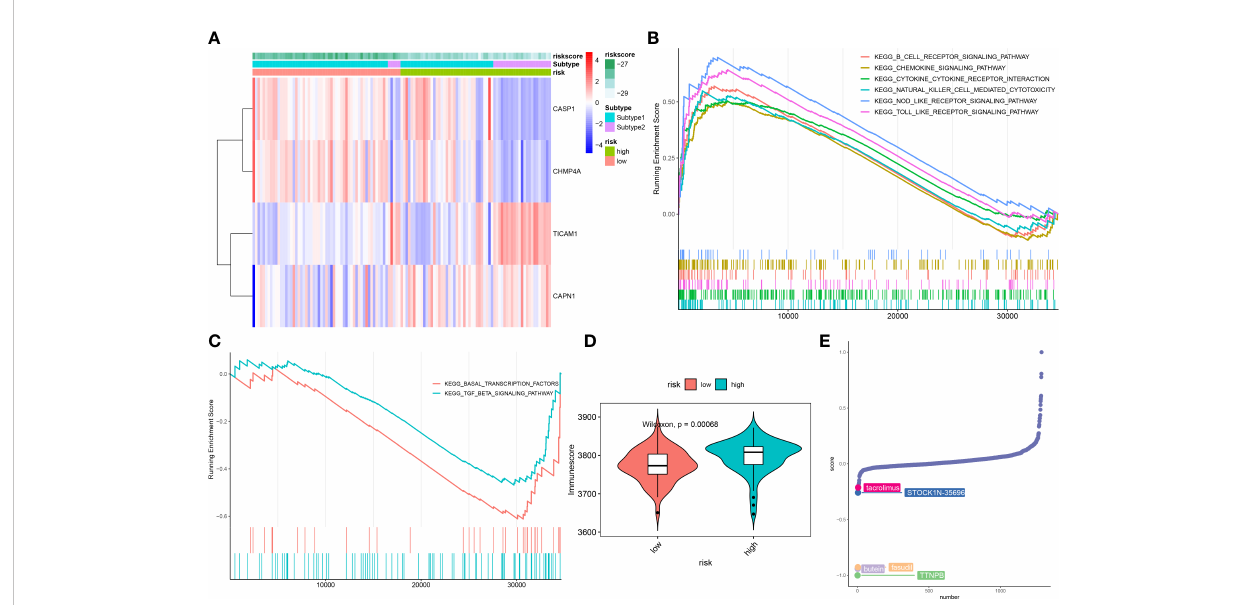
FIGURE 11 Differences in the molecular characteristics of children at low and high risk of ASD. (A) Representative heatmap revealing the expression of model genes in ASD children. (B, C) GSEA showing the upregulated (B) downregulated (C) signaling pathways between low- and high-risk groups. (D) Representative violin plot revealing the immunoscore between the low- and high-risk groups. (E) CMap analysis revealing the top 5 small molecular compounds targeting high-risk children.